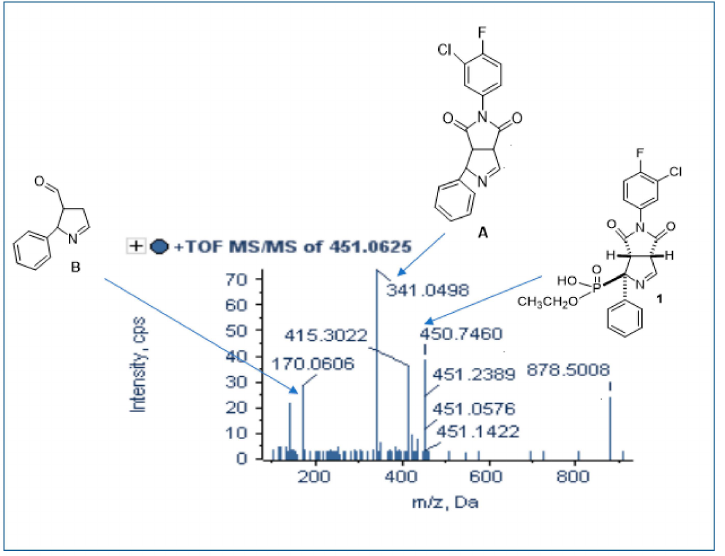
Figure 6. MS/MS spectra at 15 min of the characteristic fragmentation pattern of B06 metabolite 1 in